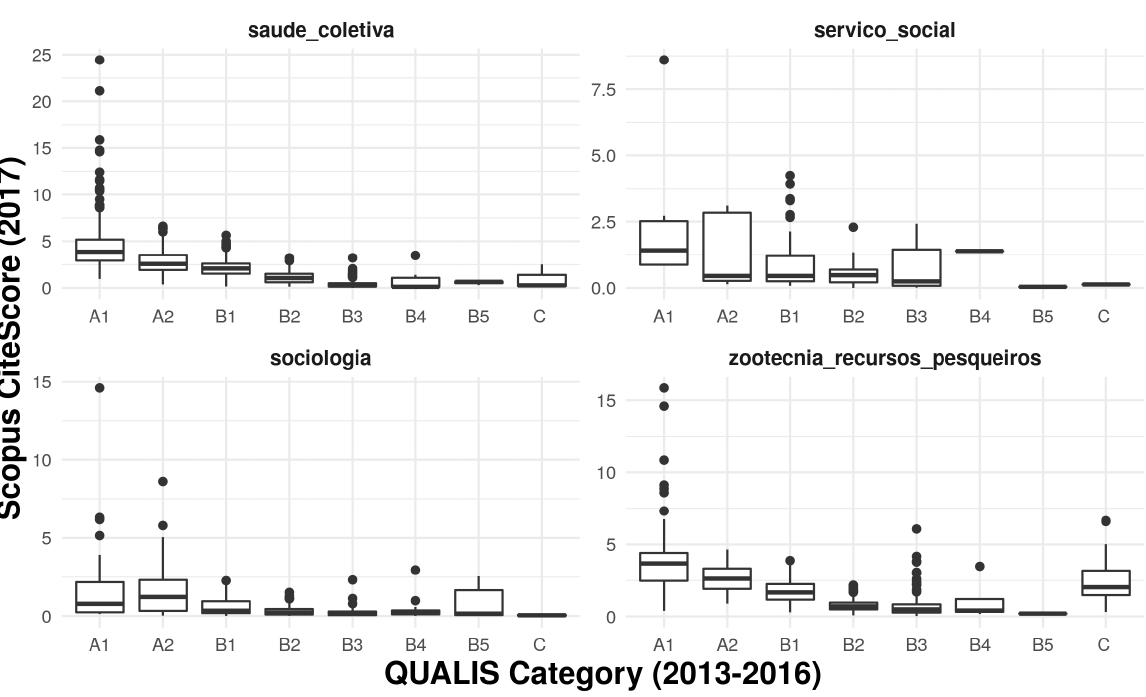
Figure 8. Scopus CiteScore variation across QUALIS categories in four subject area. Original QUALIS subject area names are shown (as written in their respective classification sheets) but their English translation can be found in Table